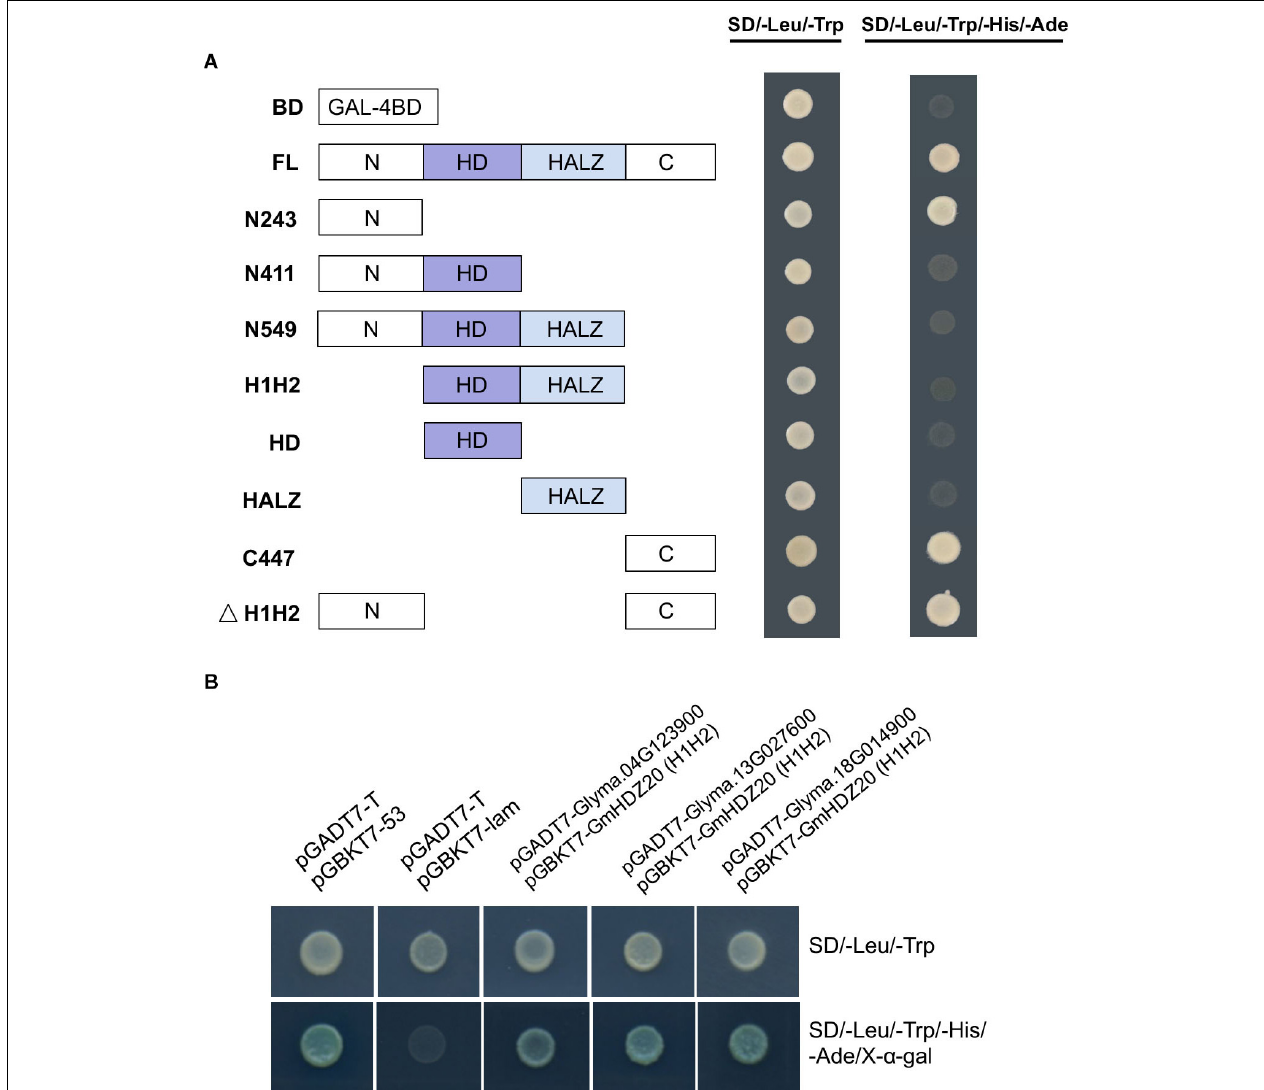
FIGURE 10 | Identification of proteins that interacted with GmHDZ20 by the yeast two-hybrid assay. (A) Transactivation assay of different parts of GmHDZ20 in yeast strain Y2H-Gold. BD, empty pGBKT7 vector; FL, full-length GmHDZ20 ; N243, GmHDZ20 N terminus with 243 nucleotides (1 to 81 residues); N411, N terminus with 411 nucleotides (1 to 137 residues); N549, N terminus with 549 nucleotides (1 to 183 residues); H1H2, homeodomain and leucine zipper domain with 306 nucleotides (82 to 183 residues); HD, homeodomain with 168 nucleotides (82 to 137 residues); HALZ, leucine zipper domain with 138 nucleotides (138 to 183 residues); C447, C terminus with 447 nucleotides (184 to 332 residues); (cid:49) H1H2, N and C termini with 243 nucleotides (1 to 81 residues and 184 to 332 residues, respectively). (B) Three proteins interacted with GmHDZ20. Yeast two-hybrid assays were carried out between these three fusion AD proteins and the H1H2 fragment of GmHDZ20 (306 nucleotides; 82 to 183 residues) fused to BD bait. Positive: pGADT7-T and pGBKT7-53 plasmids; Negative: pGADT7-T and pGBKT7-lam plasmids.